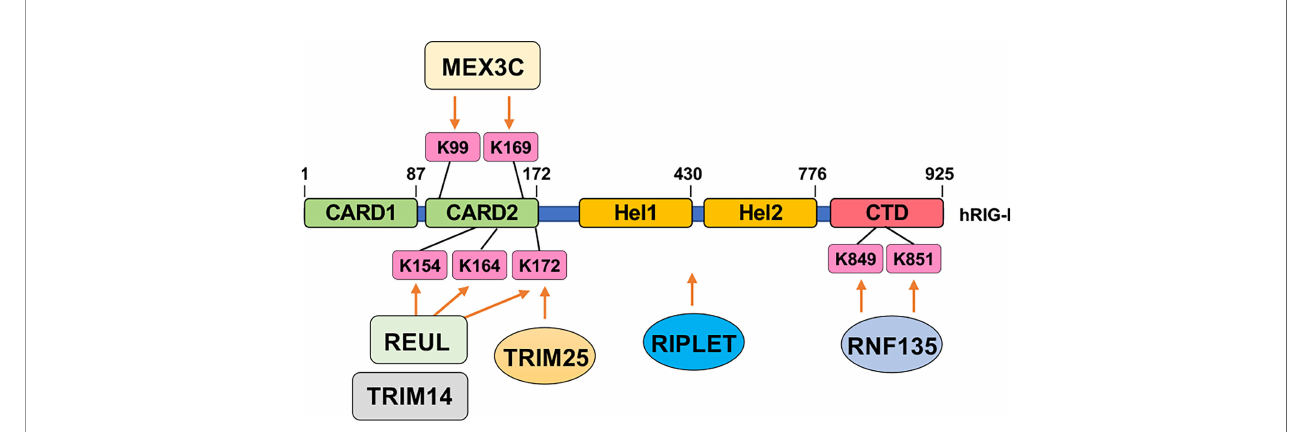
FIGURE 3 | Ubiquitination-mediated RIG-I activation. Indicated E3 ubiquitin ligases add on K63-linked ubiquitin chains to indicated residues in RIG-I to facilitate RIG- I activation upon sensing